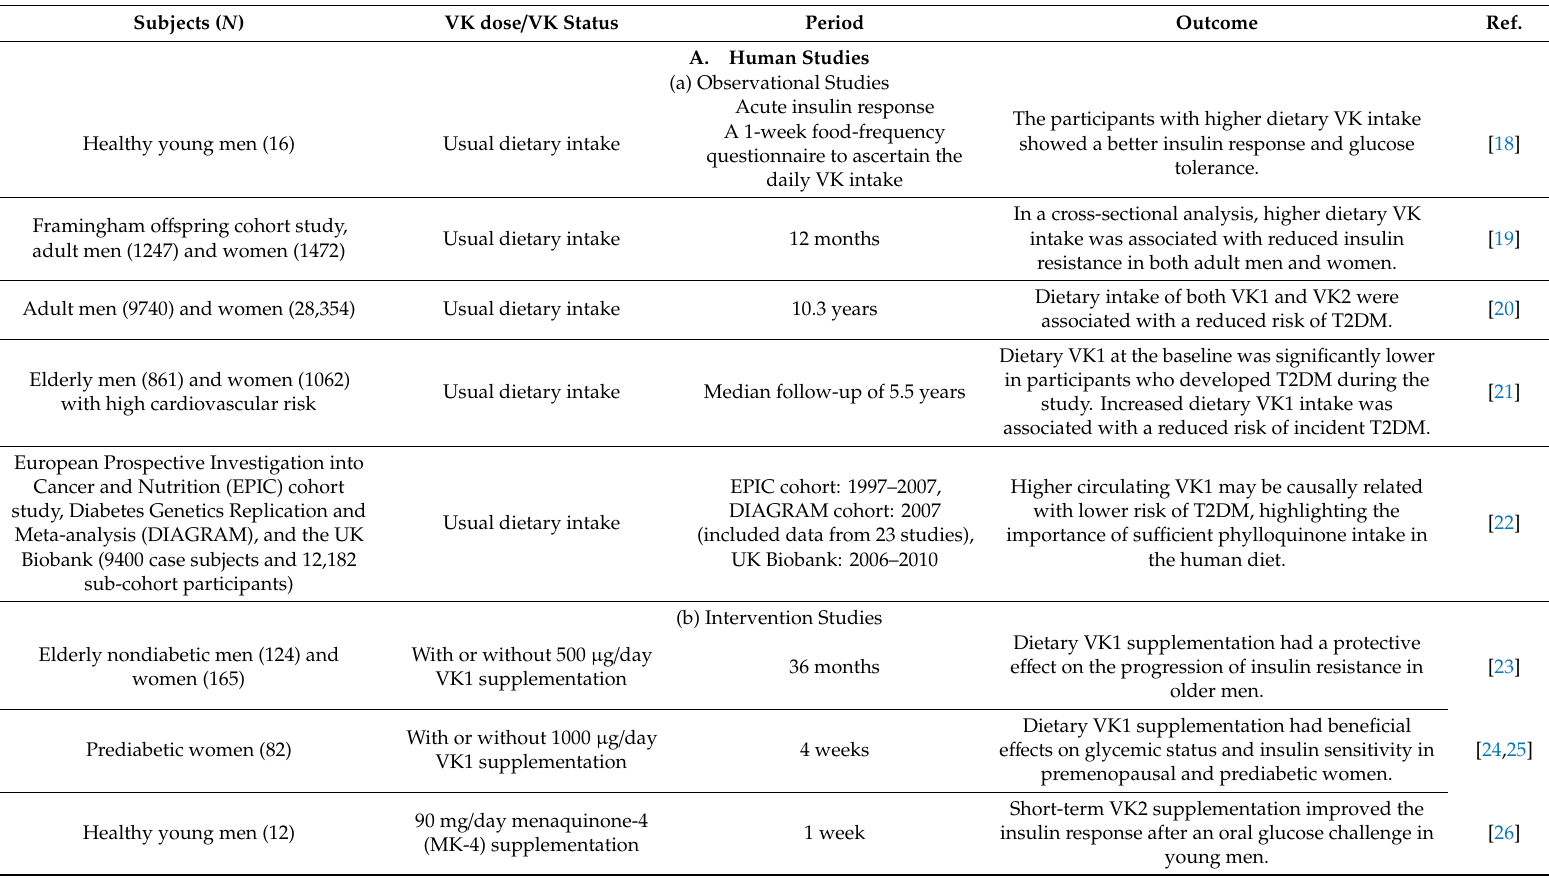
Table 1. Summarization of findings from studies on the e ff ect of vitamin K on insulin sensitivity and glycemic